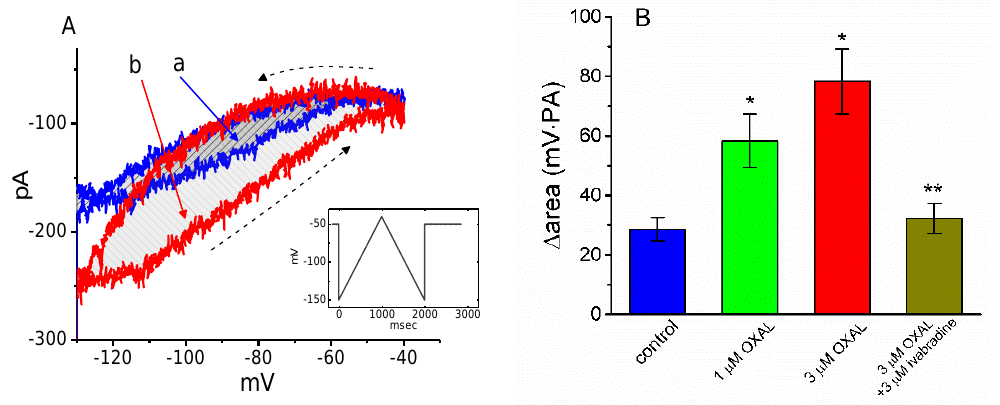
Figure 4. The e ff ect of OXAL on the voltage-dependent hysteresis measured from GH 3 cells. ( A ) Representative current trace elicited by long-lasting, 2 s triangular (i.e., upsloping and downsloping) ramp pulse between − 150 and − 40 mV. Insert in ( A ) is the voltage protocol applied during the recordings. ( A ) Voltage hysteresis (i.e., forward or reverse current versus voltage relationship) of I h measured in the absence (a) and presence of 3 µ M OXAL (b). Arrow depicts the direction of ramp-elicited I h in which time passes. The current trace labeled a was the control and that labeled b was taken in the presence of 3 µ M OXAL. ( B ) Summary bar graph showing the e ff ect of OXAL and OXAL plus ivabradine on the ∆ area (as indicated in shaded area in ( A )) of voltage hysteresis (mean ± SEM; n = 9 for each bar). ∆ Area taken with or without addition of OXAL is indicated as shaded area in ( A ). * Significantly di ff erent from control ( p < 0.05) and ** significantly di ff erent from 3 µ M OXAL alone group ( p < 0.05).